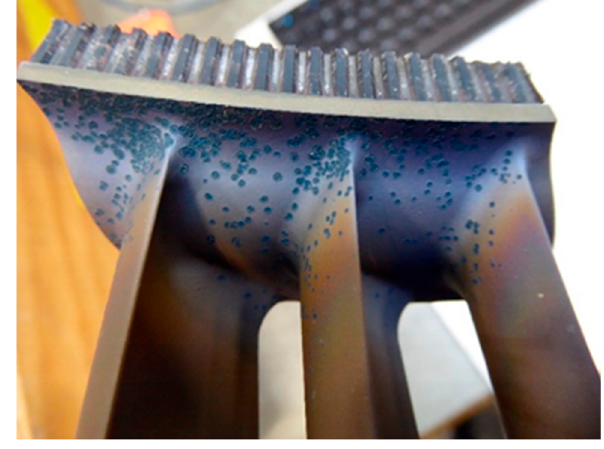
Figure 4 . Corrosion effect on a LPT vane [52]. Figure 4. Corrosion effect on a LPT vane [52].